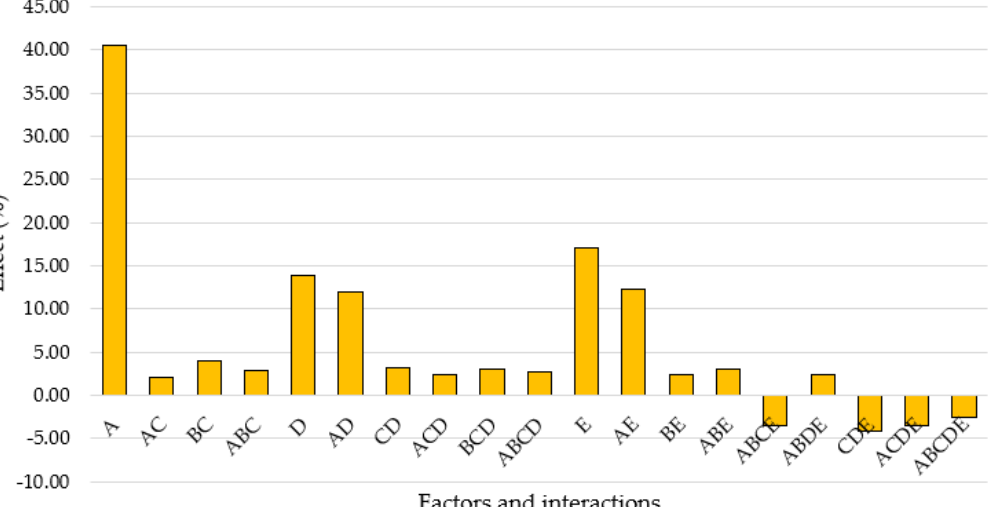
Figure 5. Main factors and their interaction effects on Pt leaching.